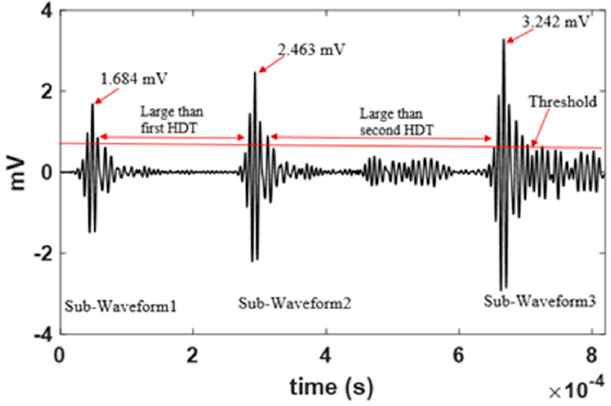
Figure 13. Waveform recorded by the first channel with a HDT of 200 µ s.